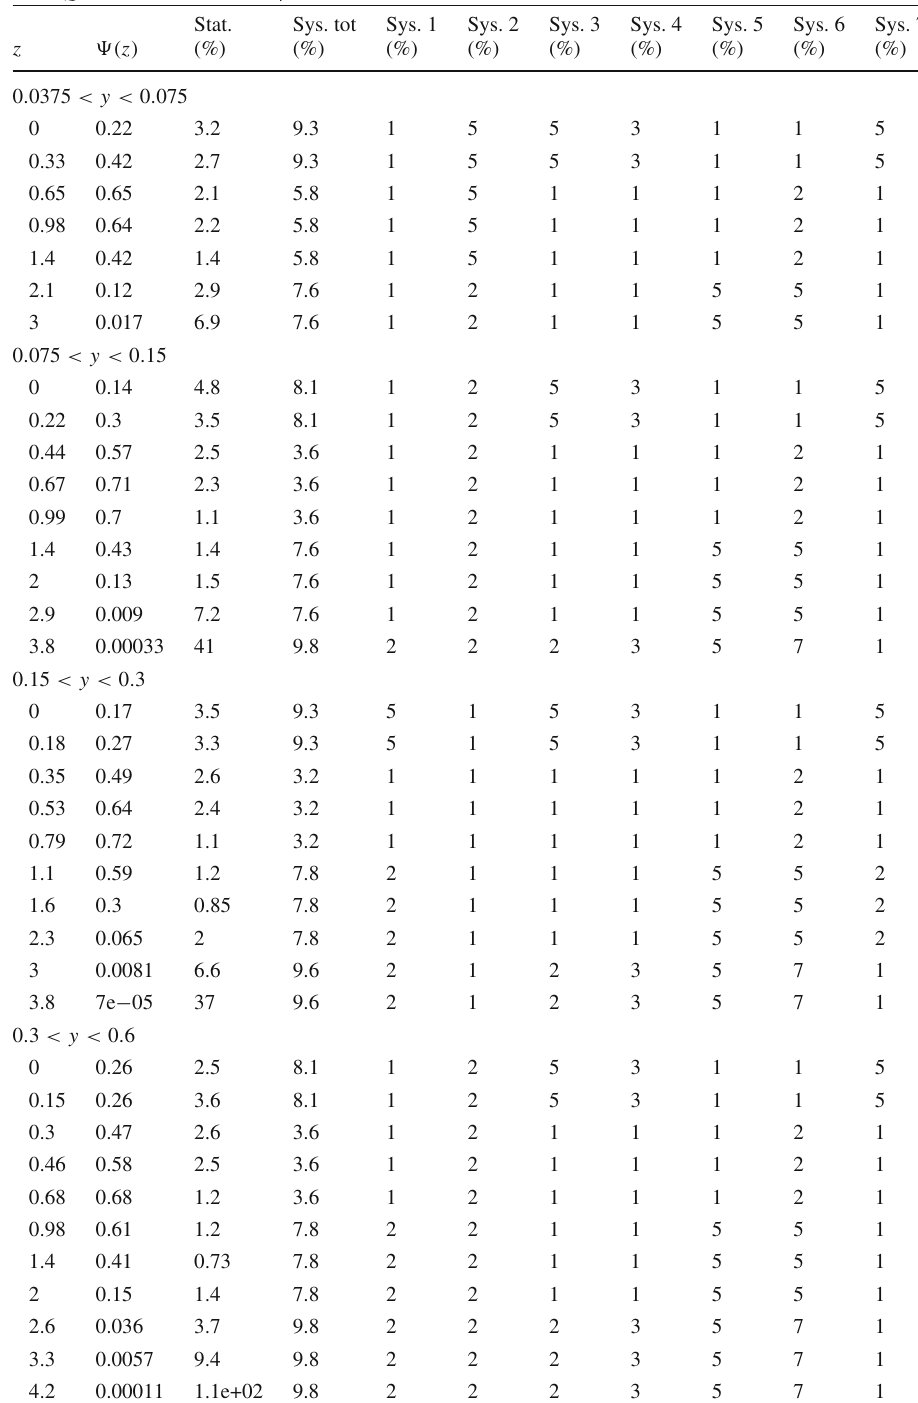
KNO function of multiplicity distributions in